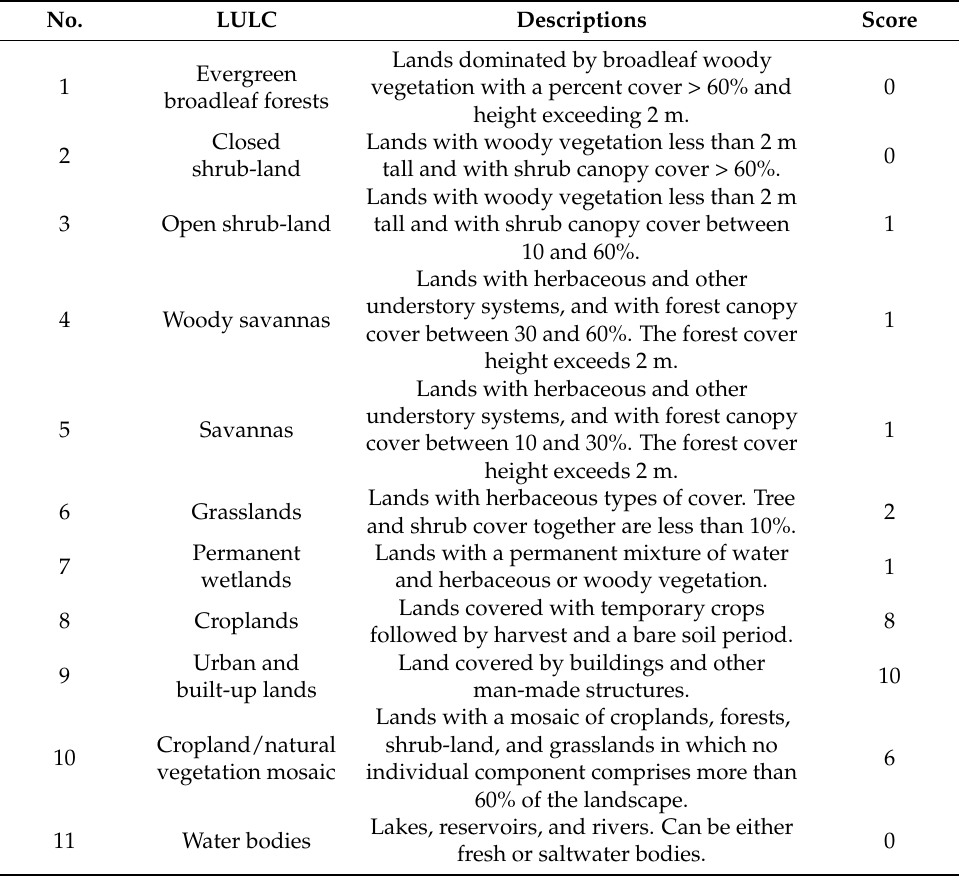
Table 1. International Geosphere-Biosphere Programme (IGBP) land use/land cover (LULC) types and the human influence scores of each